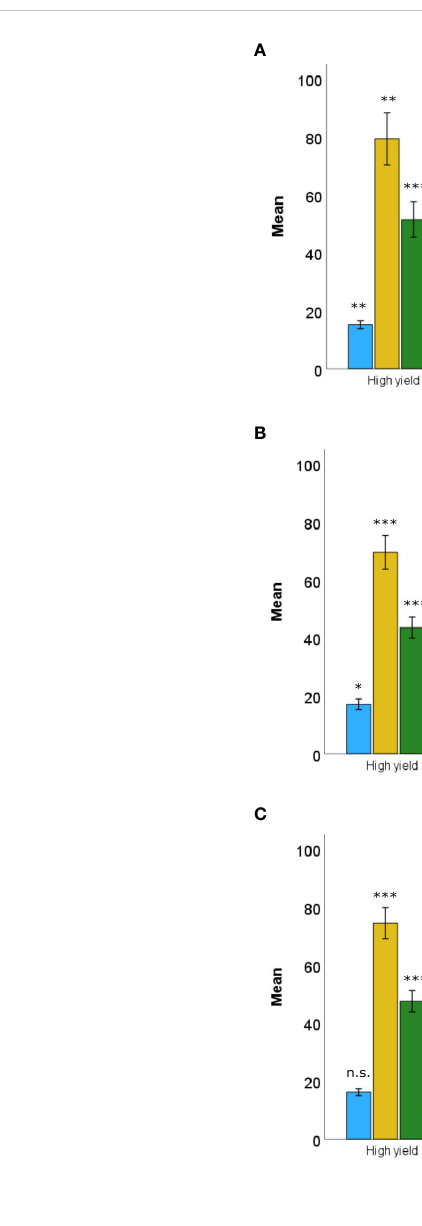
FIGURE 5 Comparison between U Nitrogen uptake ef fi ciency, EN Grain-speci fi c Nitrogen ef fi ciency, EN,yp Protein-speci fi c Nitrogen ef fi ciency, and EN,ys Starch-speci fi c Nitrogen ef fi ciency for three wheat types corresponding to nine spring wheat varieties grown in central Sweden in 2018 (A) , 2019 (B) and the combined years (C) . Bars represent the mean values of each parameter. Wheat varieties High yield wheat type (I) , Organic high protein wheat type (II), and Intermediate wheat type (III). ***, ** and * denote signi fi cant differences at P<0.001, P<0.01 and P<0.05, respectively, n.s. denotes non-signi fi cant